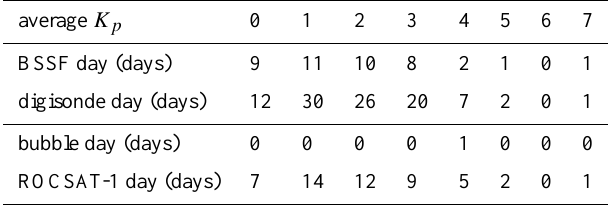
Table 4. Numbers of BSSF day, digisonde day, bubble day, and ROCSAT-1 day for each average K p in the winter